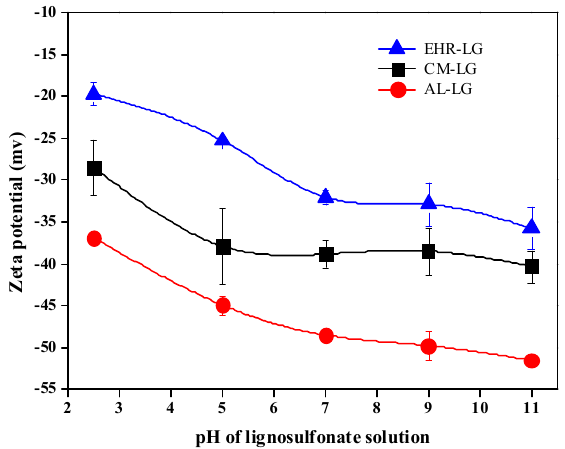
Figure 3. The zeta potential of lignosulfonate solutions across pH.